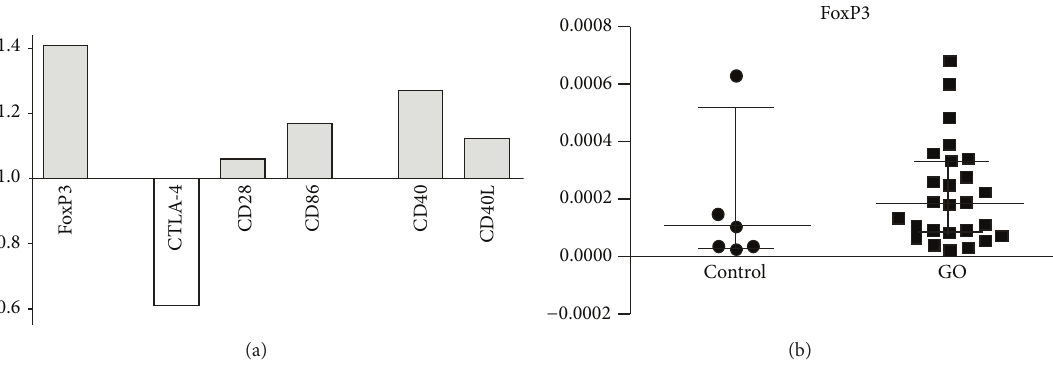
Figure 3: (a) Quantitative RT-PCR validation of the mRNA expression changes for the CD86/CD28/CTLA-4: FOXP3 and CD40/CD40L molecules in GO (mild + severe) orbital tissues compared to control tissue samples. The values above “1.0” on the 𝑦 -axis show the relative higher expression in GO versus control samples and values below “1.0” indicate relatively lower expression. (b) The individual data from RT-PCR displaying the expression of mRNA for transcription factor FoxP3 in control and examined (GO) samples (medians and 25th–75th percentiles) ( 𝑃 < 0.05